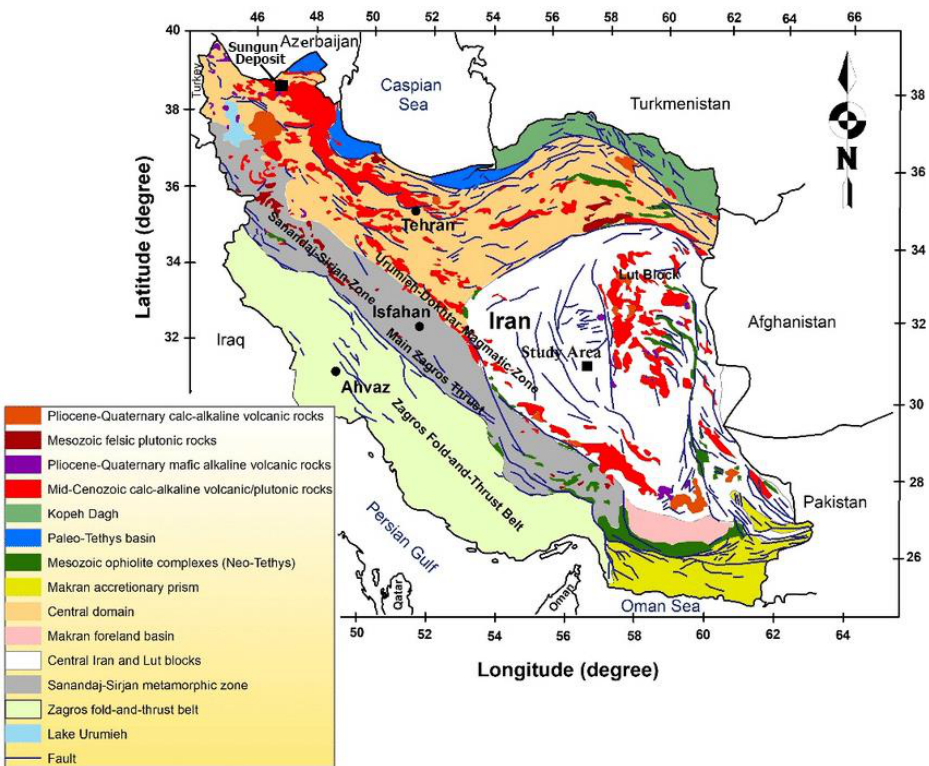
Figure 1. Regional tectonic map of Iran [12] showing the location of the study area. Among the dyke generations observed at Sungun, diorite dykes (“Pulse 1” of [11])